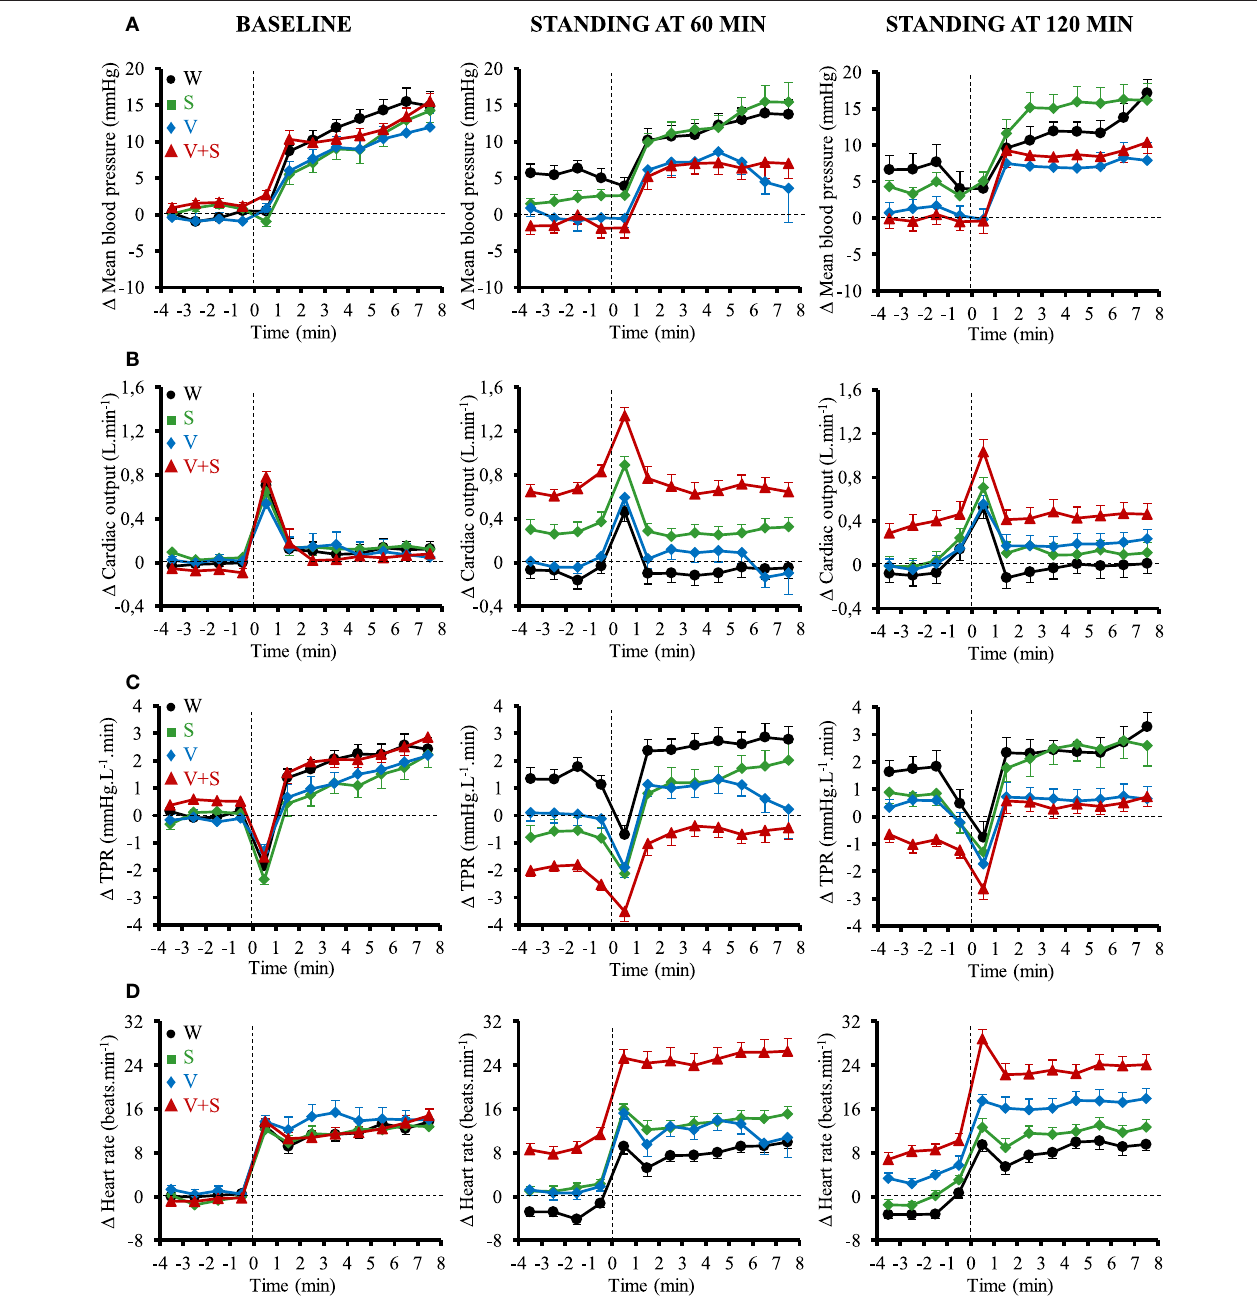
FIGURE 6 | Time course of the changes in mean blood pressure (A) , cardiac output (CO) (B) , total peripheral resistance (TPR) (C) , and heart rate (D) 4min before standing and during the first 8min of active standing during baseline and after 60 and 120min post-ingestion. Data are relative to baseline values prior to drink ingestion. Drinks: water (W) , ; water + sugar (S) , ; water + vodka (V) , ; water + vodka + sugar (V + S) ,